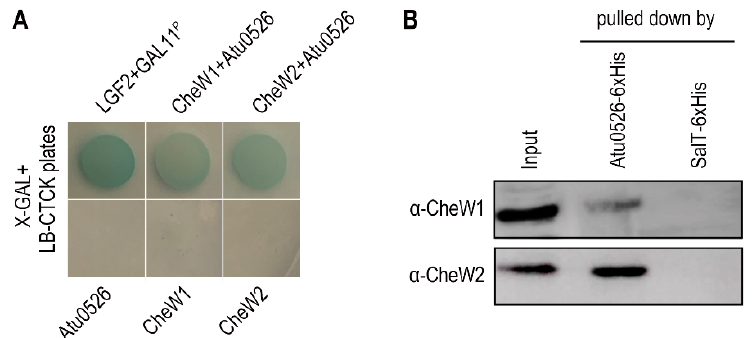
Figure 2. The interaction between Atu0526 and CheWs. ( A ) Bacterial two-hybrid for testing the interactions between Atu0526 and CheWs. The bacterial cells harboring positive control proteins or different combinations of Atu0526 and CheWs were spotted on LB-CTCK plates with X-GAL. Bacterial cells can grow on the plate and appear blue, indicating an interaction between proteins. ( B ) Pull-down assay for testing the interactions between Atu0526 and CheWs. The 6 × His-tagged Atu0526 and SalT were incubated with the crude extraction of A. fabrum C58 and then pulled down by Ni-IDA Resins. The eluted solutions were subsequently immunoblotted with the antibodies against two CheWs [42] Original blot images in Supplementary Figures S1 and S2.